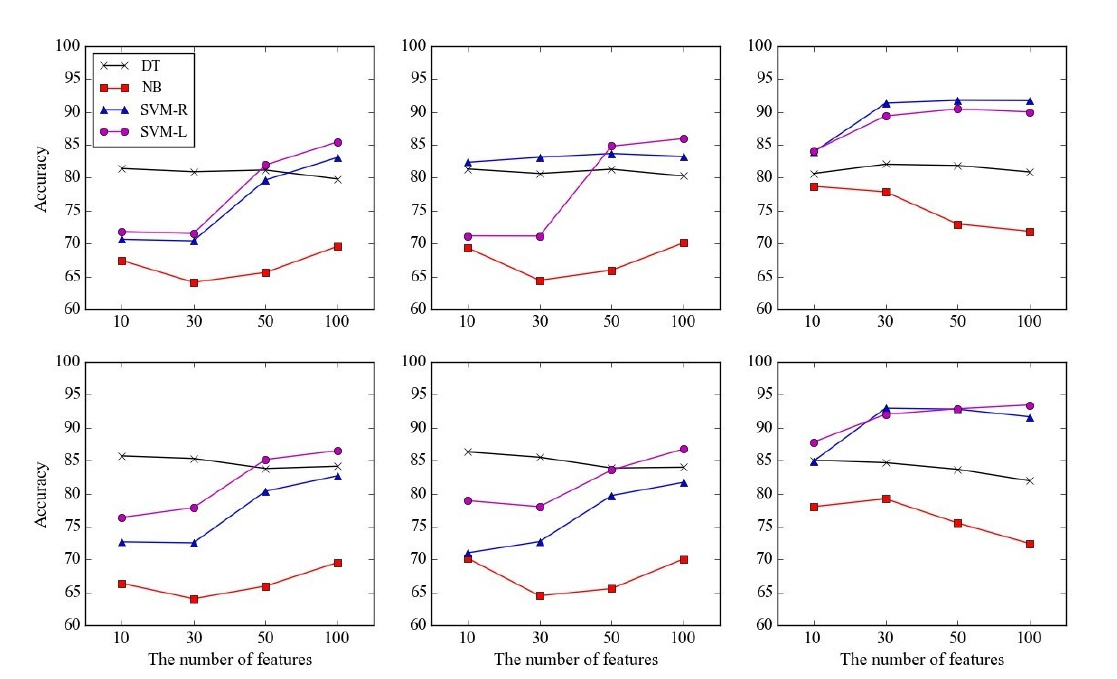
Figure 8. Performances of the proposed framework using the selected features according to the number of selected features and detection methods in terms of data utilized: ( upper ) audio only and ( lower ) audio and heart rate, and feature selection methods: ( left ) CHI , ( middle ) IG , and ( right ) SVMW.